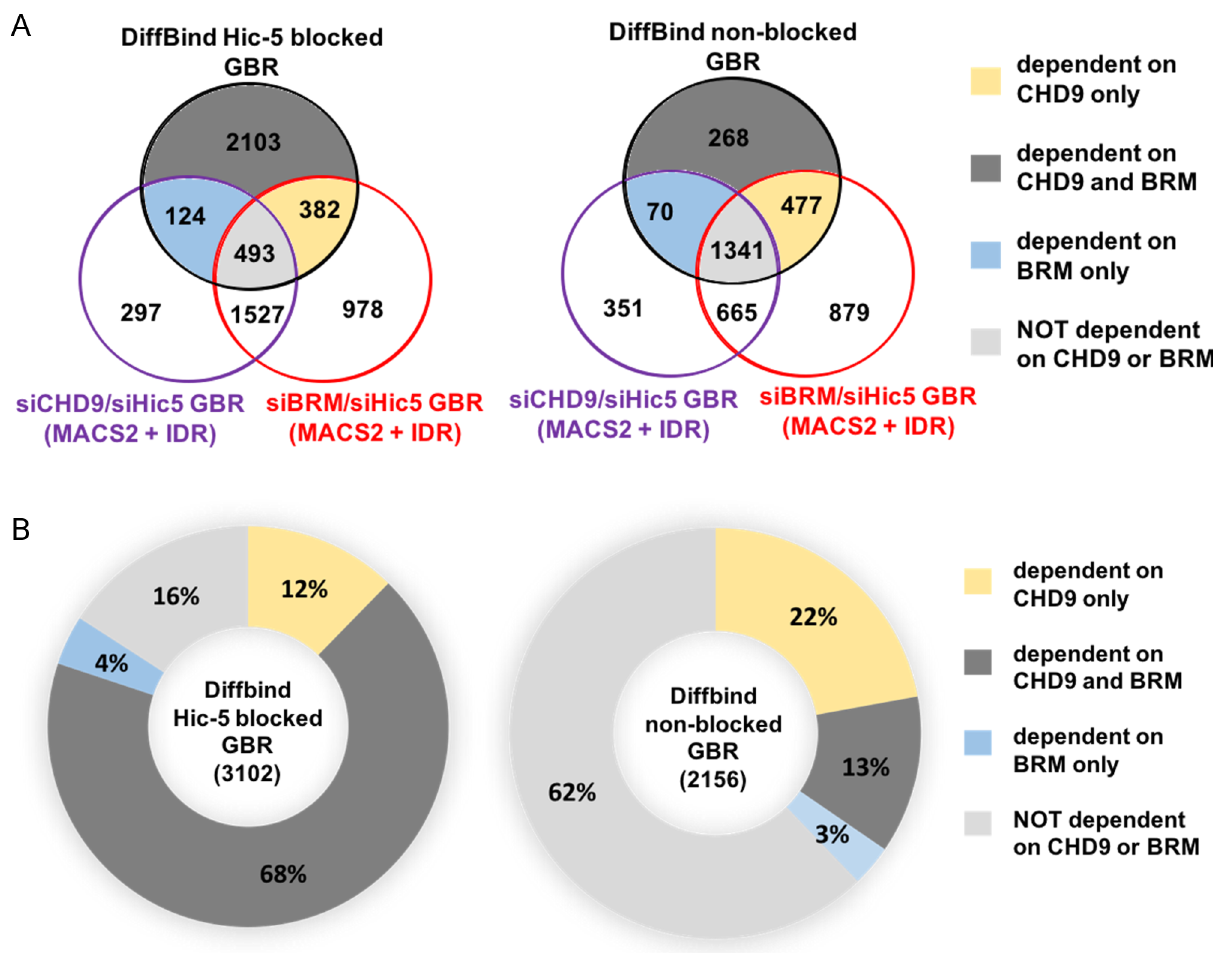
Fig 2. Hic-5 blocked GBR require CHD9 and BRM. Genome-wide GR ChIP-seq analysis was performed to evaluate the GR peaks dependent on CHD9 and BRM. (A) Three-way Venn diagram overlapping the following GBR sets: DiffBind Hic-5 blocked GBR (left) or non-blocked GBR (right) from Fig 1D; GBR in cells depleted of both CHD9 and Hic-5 (siCHD9/siHic5) from Fig 1A; and GBR in cells depleted of BRM and Hic-5 (siBRM/ siHic5) from Fig 1A. Dark grey regions, GBR dependent on CHD9 and BRM; yellow regions, GBR dependent on CHD9, not BRM; blue regions, GBR dependent on BRM, not CHD9; light grey regions, GBR not dependent on CHD9 or BRM. (B) Pie charts showing percentage of blocked or non-blocked GBR that are dependent on CHD9 and/or BRM. The number of GBR in each colored compartment from A was divided by the total Hic-5 blocked GBR or non-blocked GBR to calculate percent of the